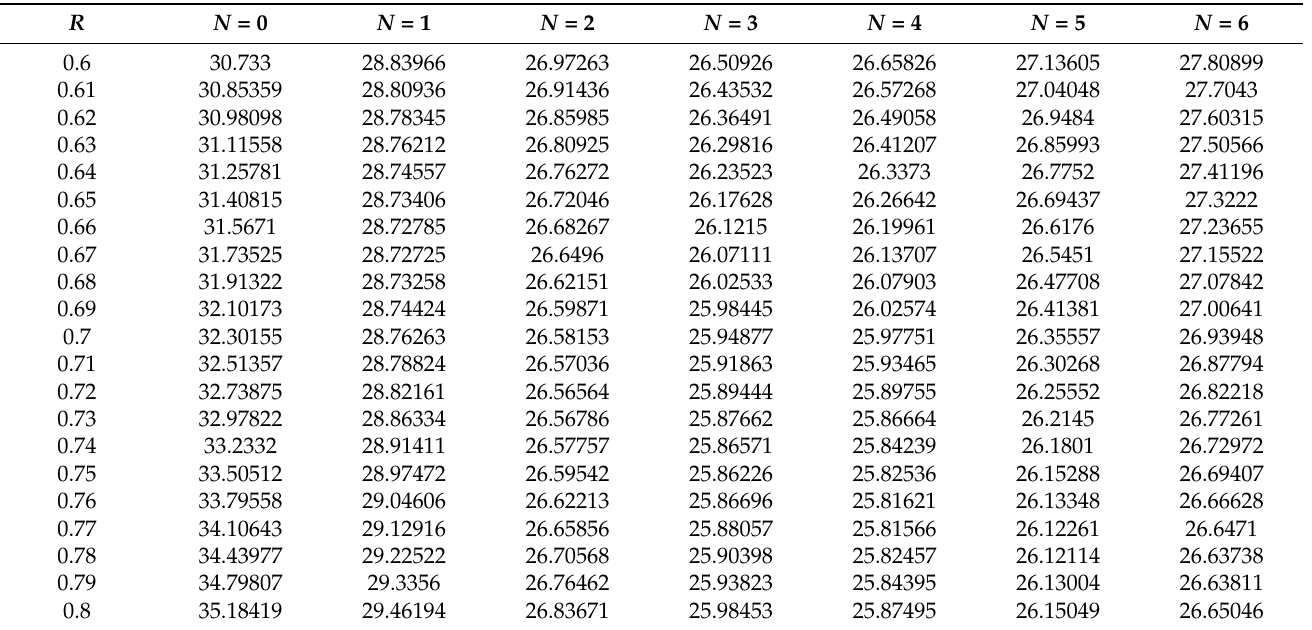
Table 2. Simulation results for maintenance costs per